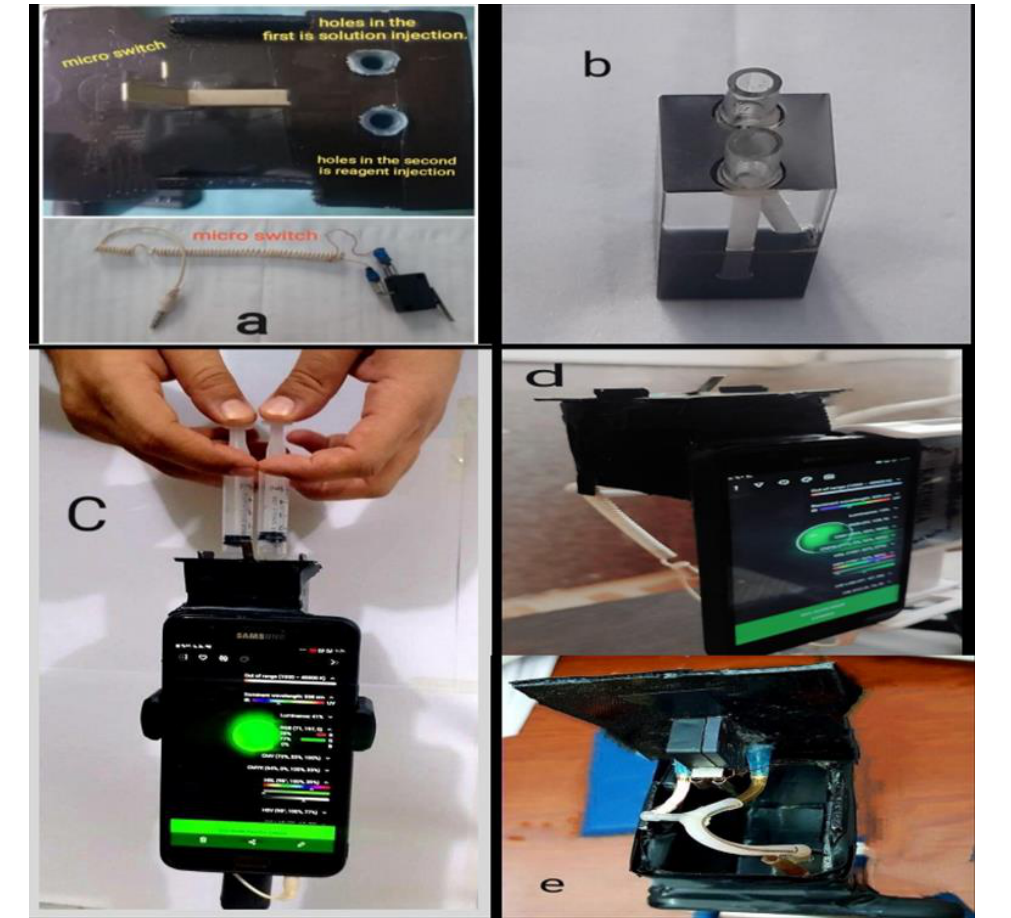
Fig. 2. The parts of the box attached to the smartphone and the way it works (a) Box cover and micro switch. (b) Flow cell. (c) Injection of samples into the flow cell. (d) The telephone set is installed on the Black box by device case. (e) The black box from the inside.